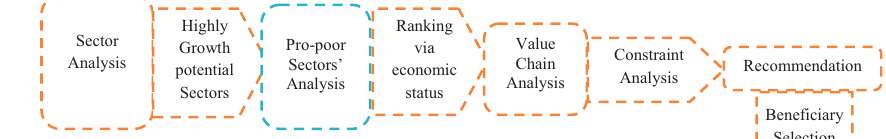
Figure 1. Normal value chain